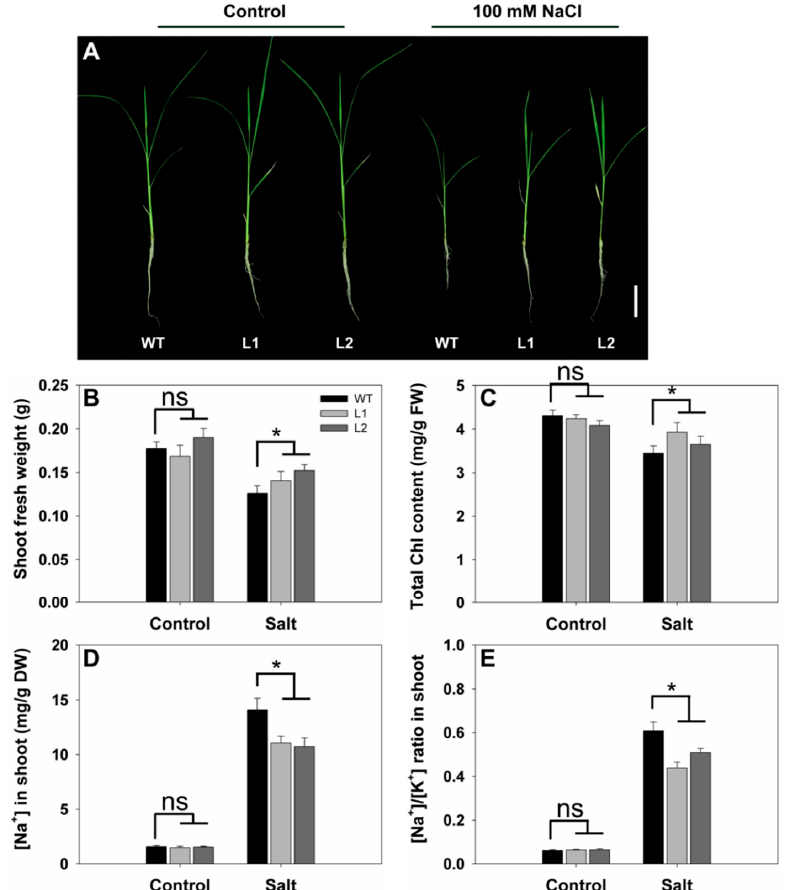
Figure 7. Growth performance in response to salinity stress of SS3p:SS3 transgenic lines compared with WT. Ten-day-old seedlings were treated for six days with or without addition of 100 mM NaCl. ( A ) Growth performance of WT and SS3p:SS3 transgenic lines under normal and 100 mM NaCl treatment. Bars = 4 cm. Shoot fresh weight ( B ), chlorophyll (Chl) content ( C ), Na + concentration ( D ), and Na + /K + ratio ( E ) in shoots of the seedlings under normal and salt stress. The values are means ± SE of five replicates. Significant differences between WT and transgenic lines at p < 0.05 are indicated with asterisks; ns denotes non-significant differences. FW—fresh weight. DW—dry weight.